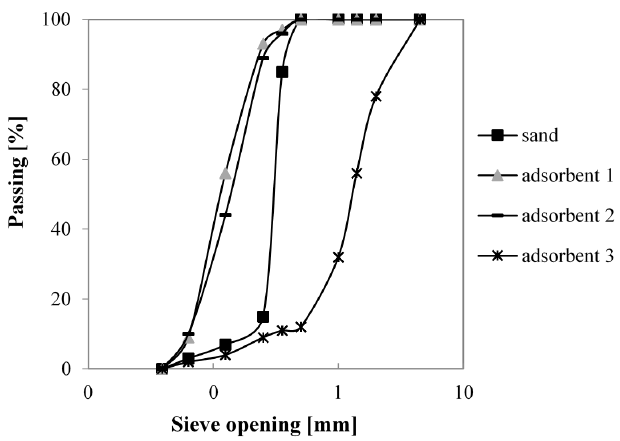
Figure 1. Grain size distribution curves of aggregates. Table 1. Properties of aggregates.